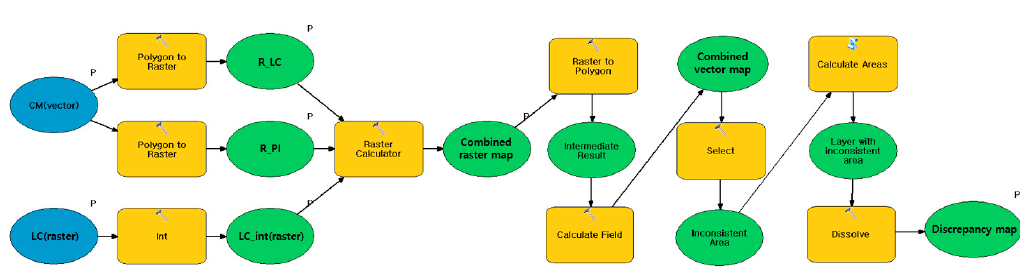
Figure 4. Automated model for detecting inconsistent area.